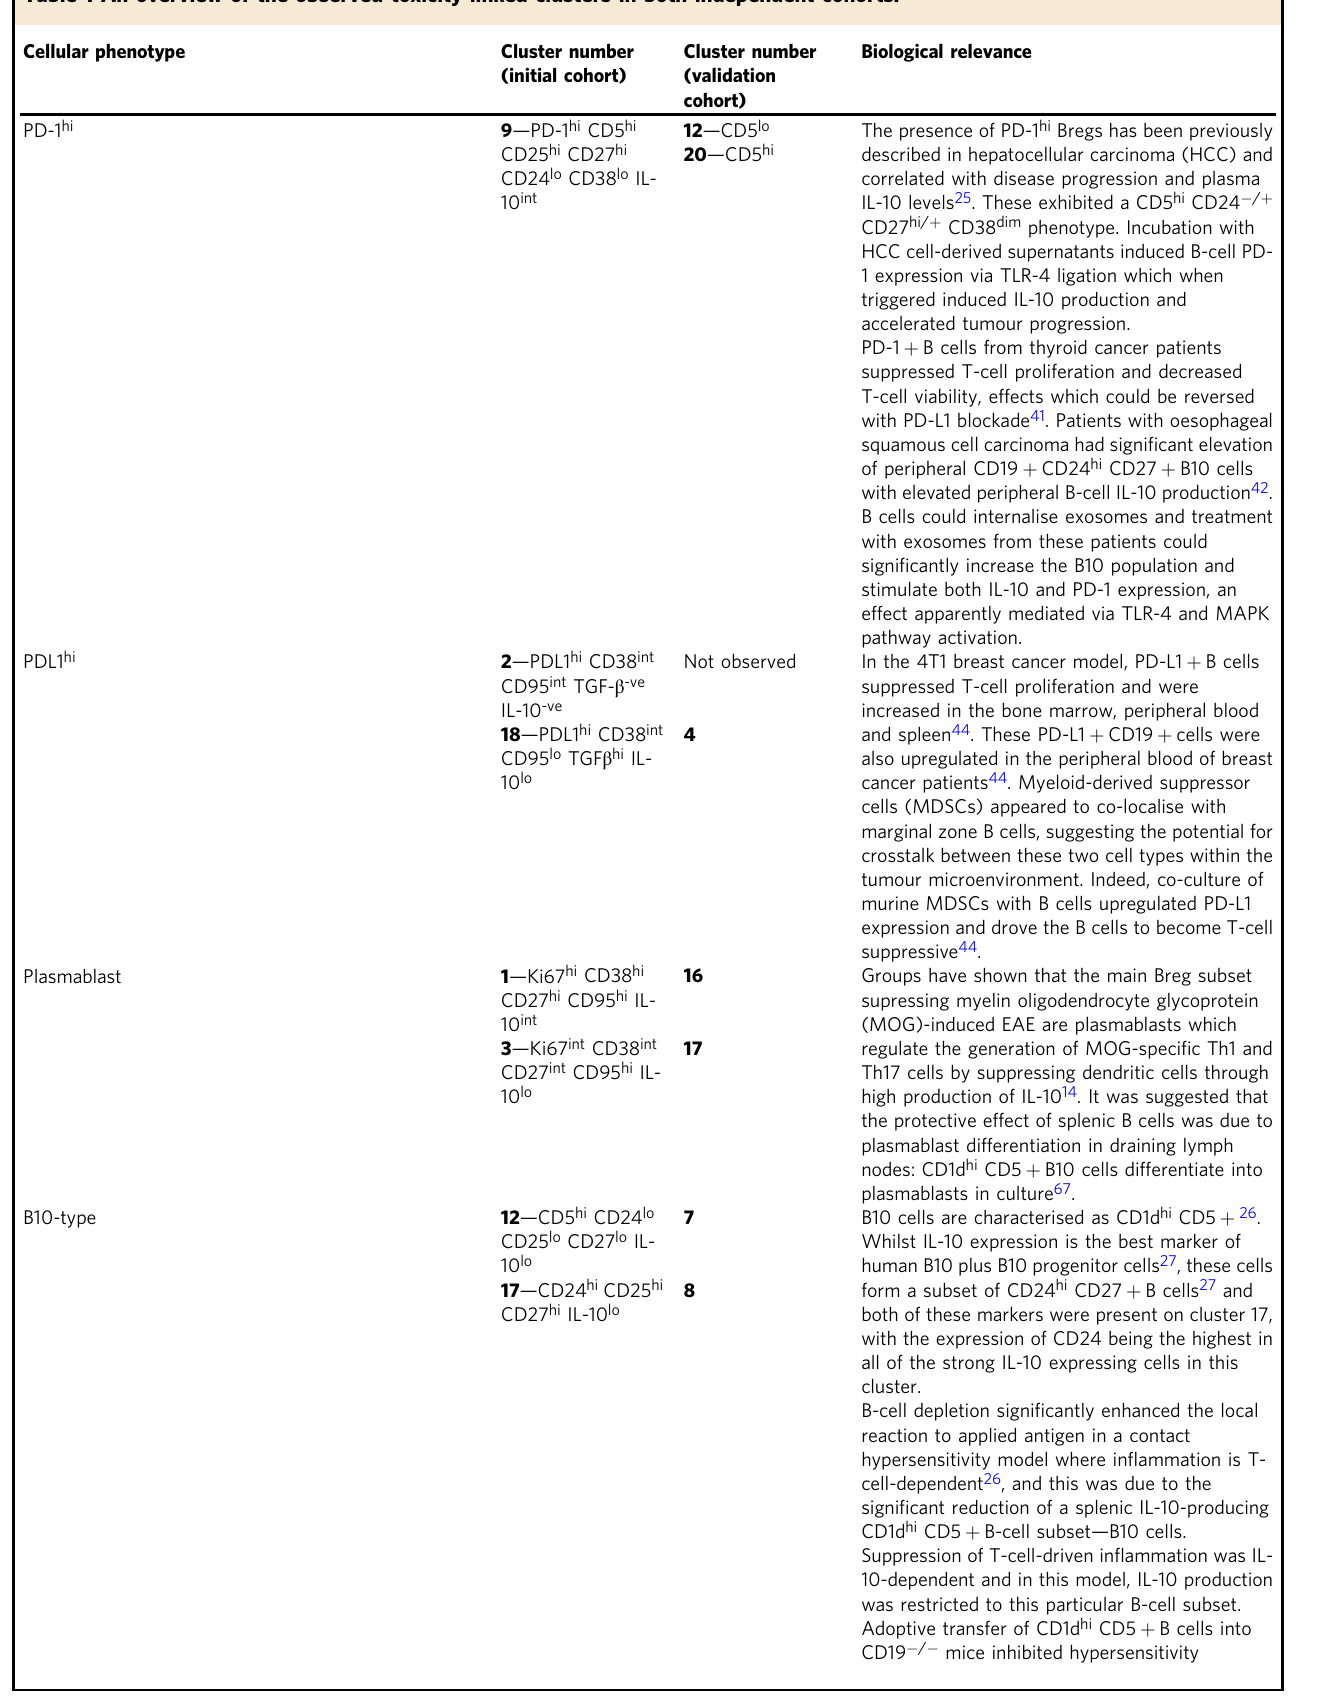
Table 1 An overview of the observed toxicity-linked clusters in both independent